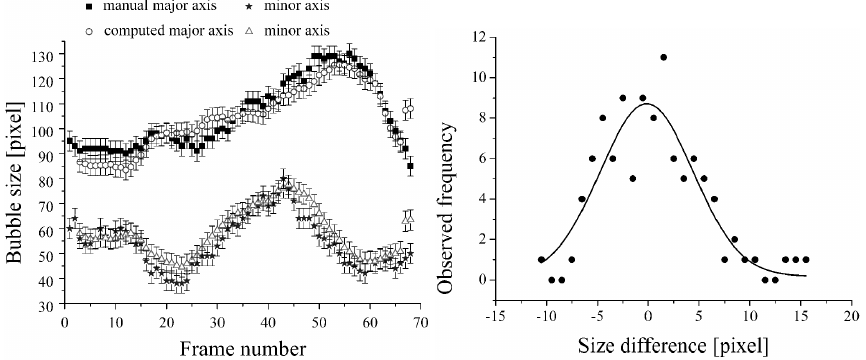
Fig. 3. Left; Comparison between manually measured and computed bubble sizes. The computed major axis (circle line) and the computed minor axis (triangle line) correspond mostly within the error of ± 4px with their manually measured counterparts. Right; The frequency distribution for size differences between manually measured and computed axes lengths can be approximated using a Gaussian fit. The error bars are consistent with the standard deviation of σ = 4 , 6 ± 0 ,